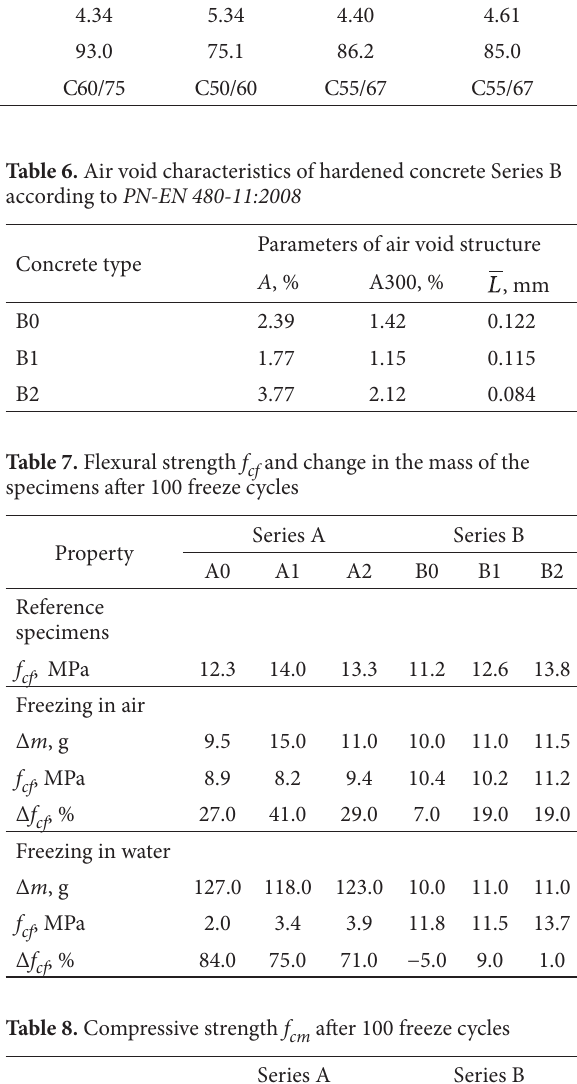
Table 5. Physical characteristics of hardened concrete Property